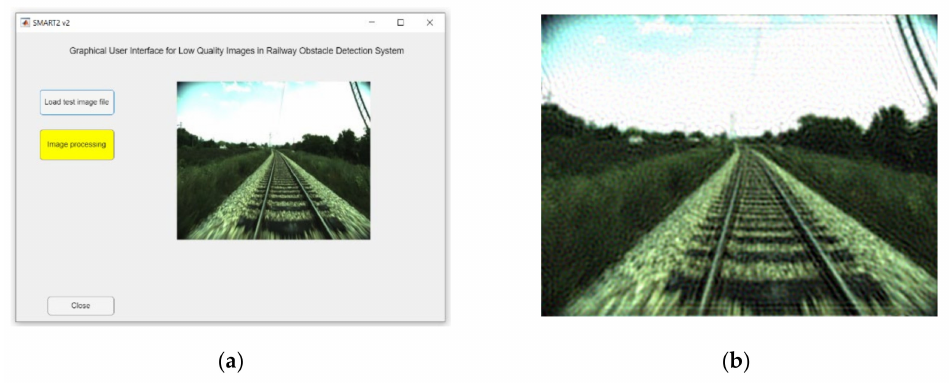
Figure 2. An example of image de-blurring: ( a ) test blurred image and graphical user interface developed in AppDesigner from MATLAB; ( b ) Image obtained by pseudo-inverse